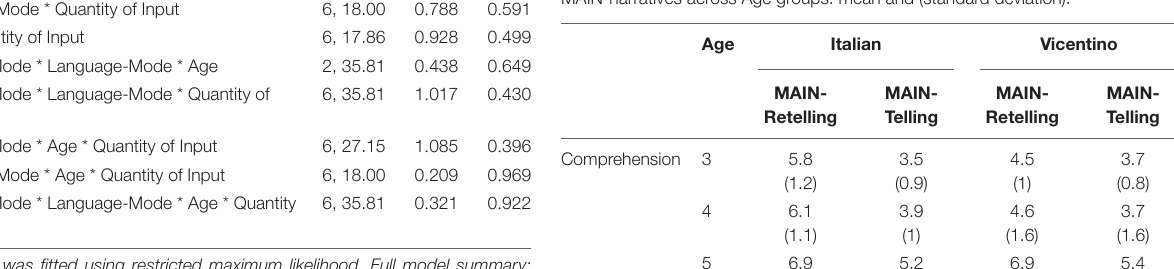
TABLE 4 | Descriptive statistics for Story Comprehension in bilingual MAIN-narratives across Age groups: mean and (standard